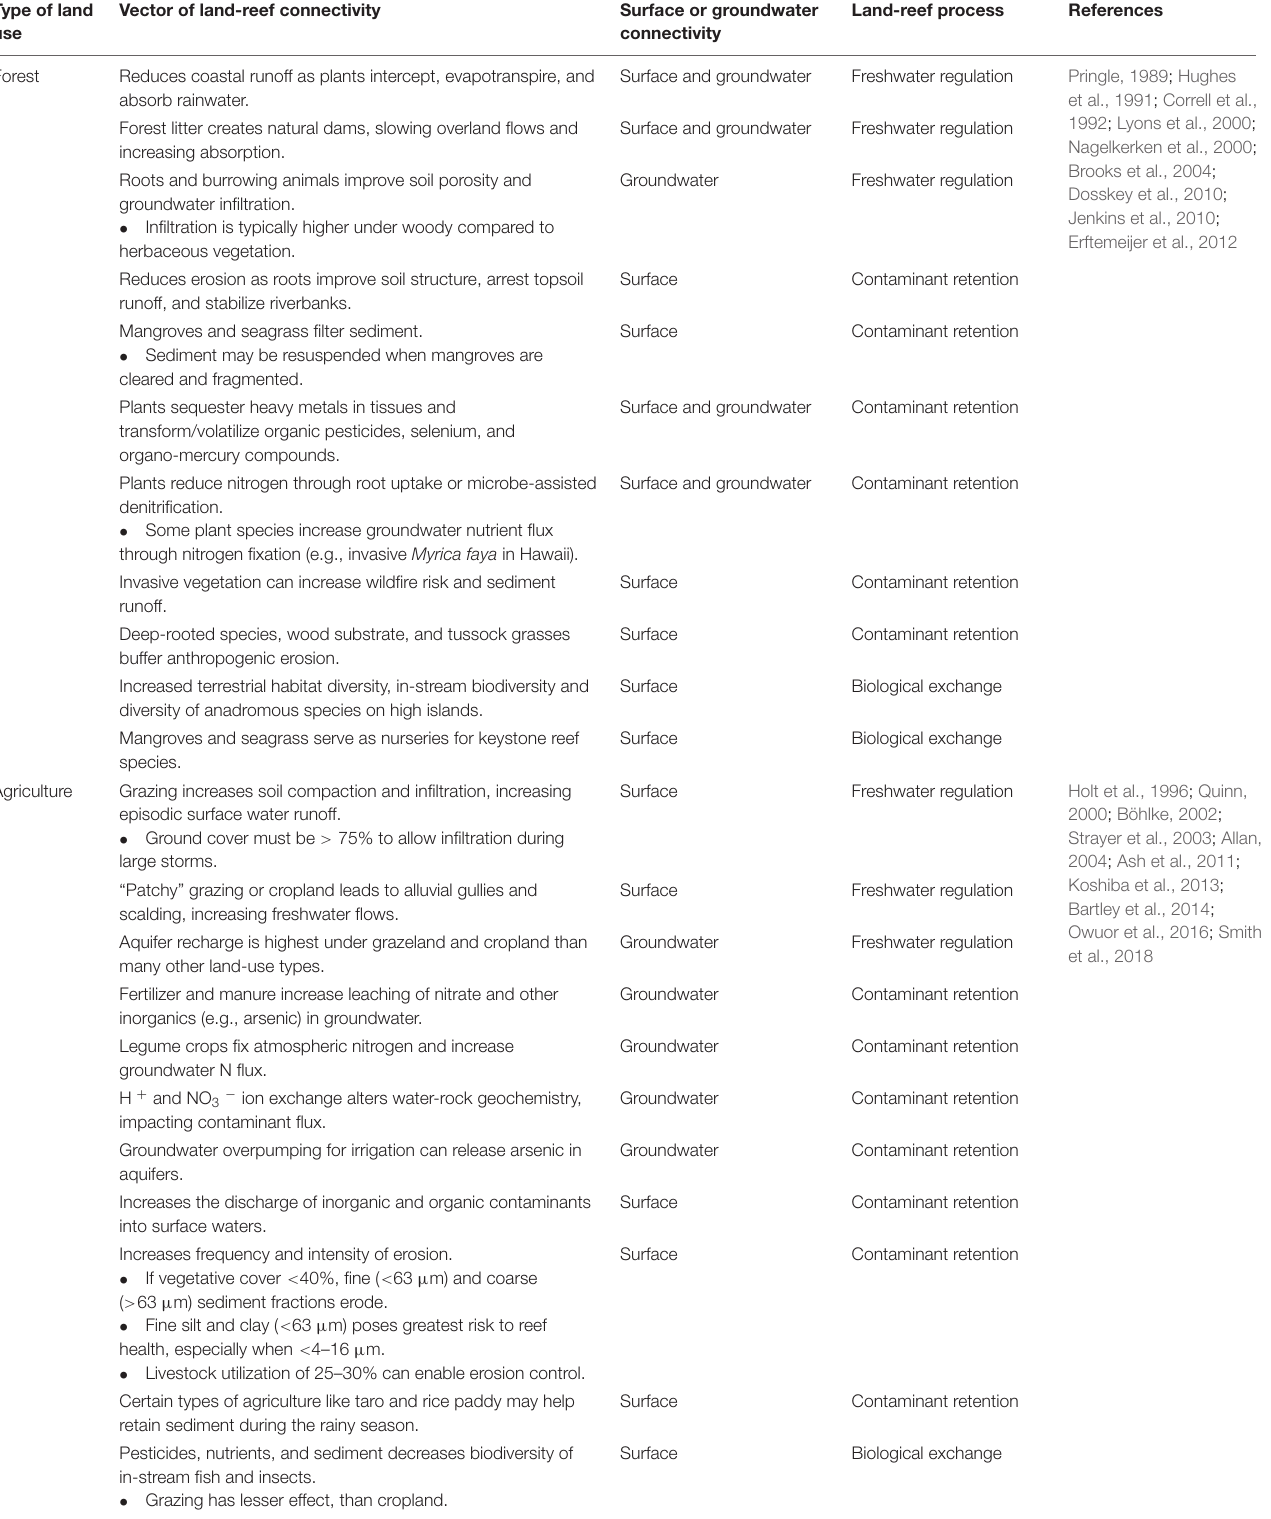
TABLE 1 | Description of land use impacts on coral reefs through freshwater regulation, contaminant retention, and land-sea biological exchange. Processes are categorized by impact on surface water and/or groundwater. Type of land Vector of land-reef use